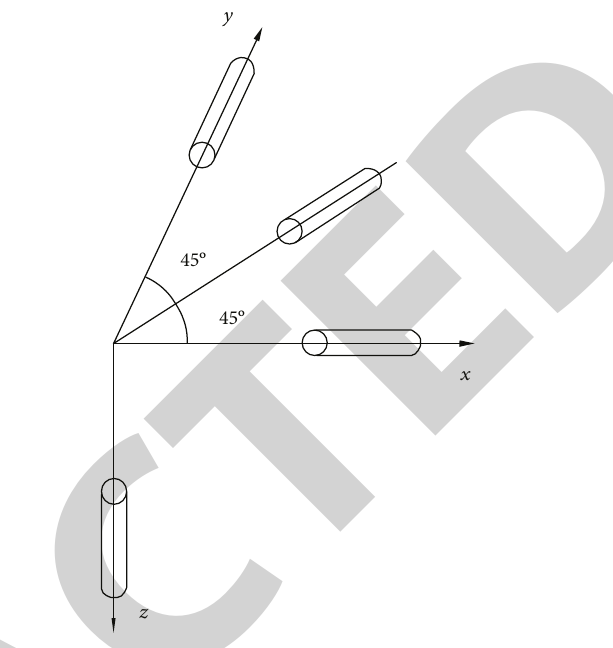
Figure 5: The schematic diagram of coring